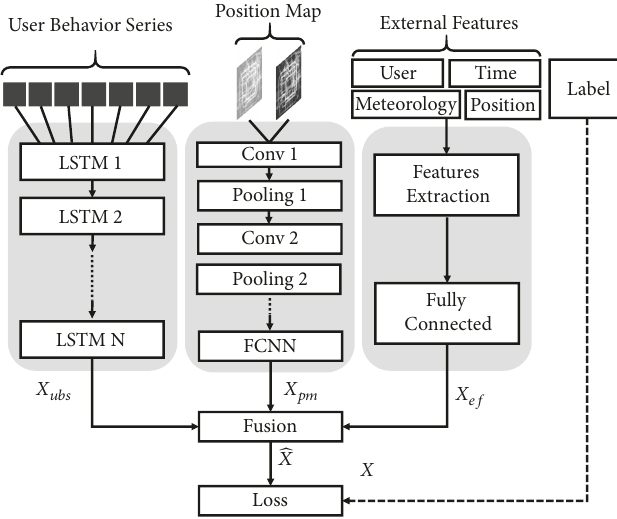
Figure 5: The network architecture.